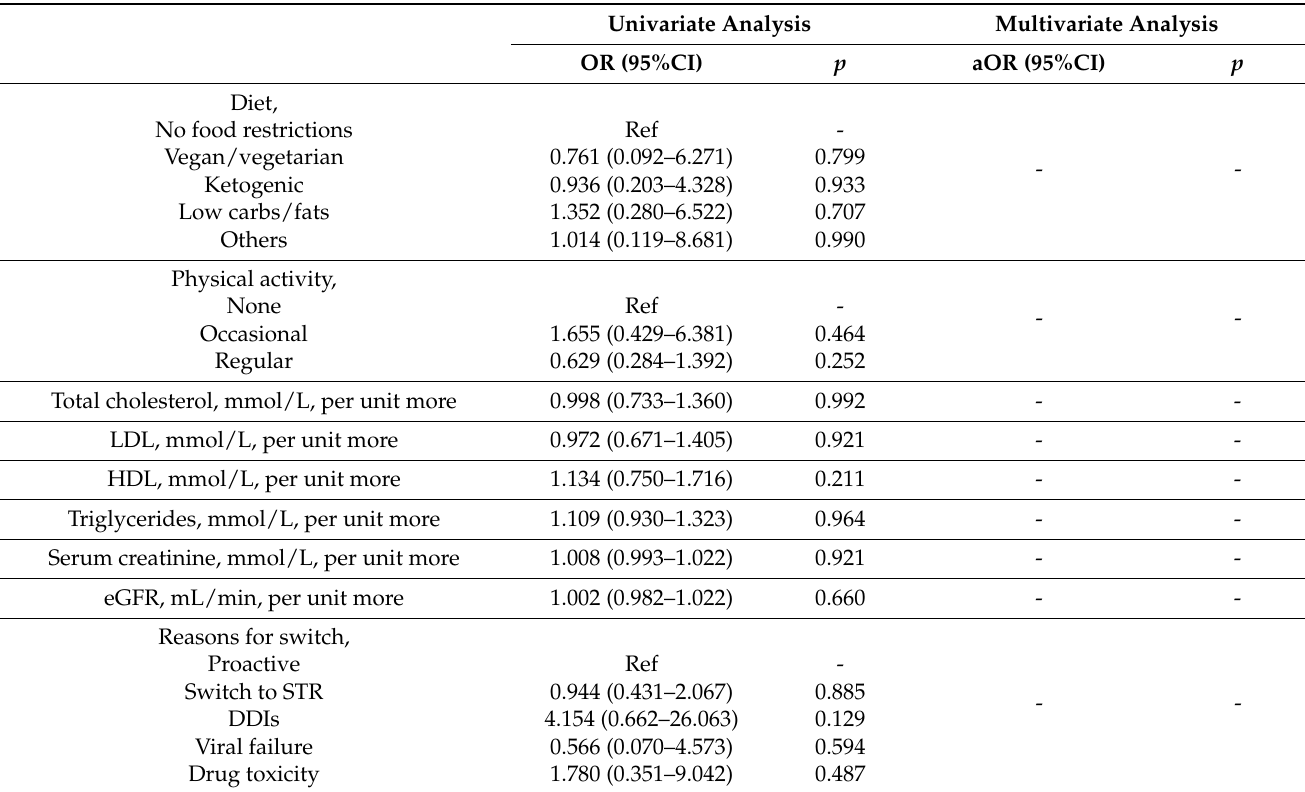
Table 3. Cont. Univariate Analysis Multivariate